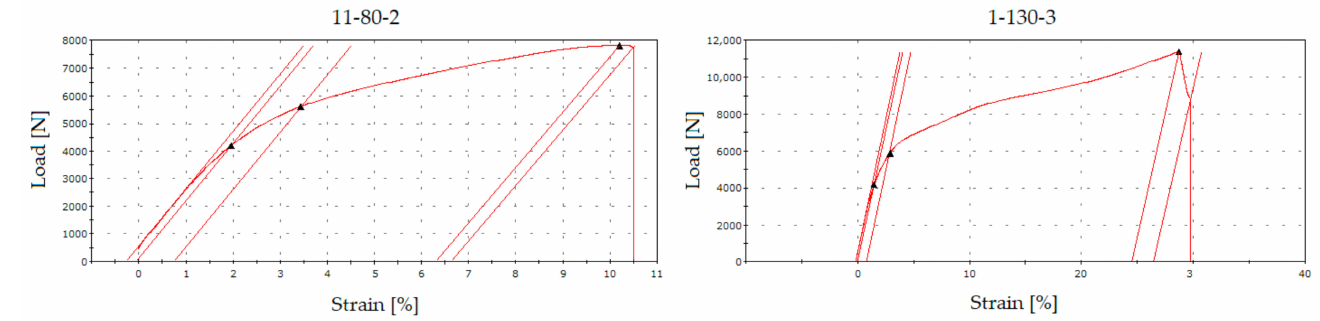
Figure 14. Comparison of tensile tests samples “1-130-2” ( right ) and carriages “11-80-2” ( left